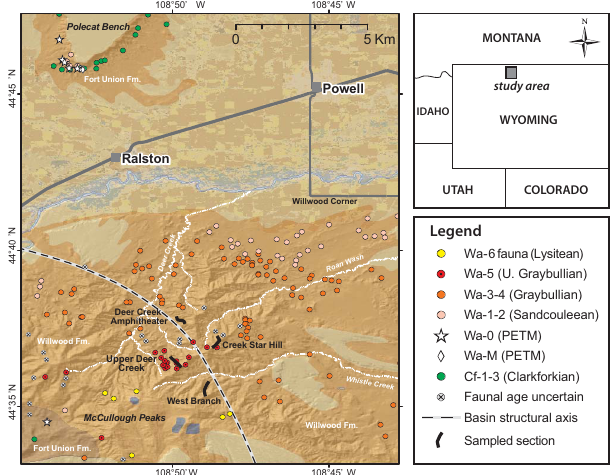
Figure 1. Location map of the sampling sites in the McCullough Peaks area of the northern Bighorn Basin in northeastern Wyoming (USA). Background colors denote topography; grey lines are roads. Indicated are the fossil localities and their interpreted Wasatchian mammal zone and the four study sections. Polecat Bench in the northwest of the study sites is the location of the